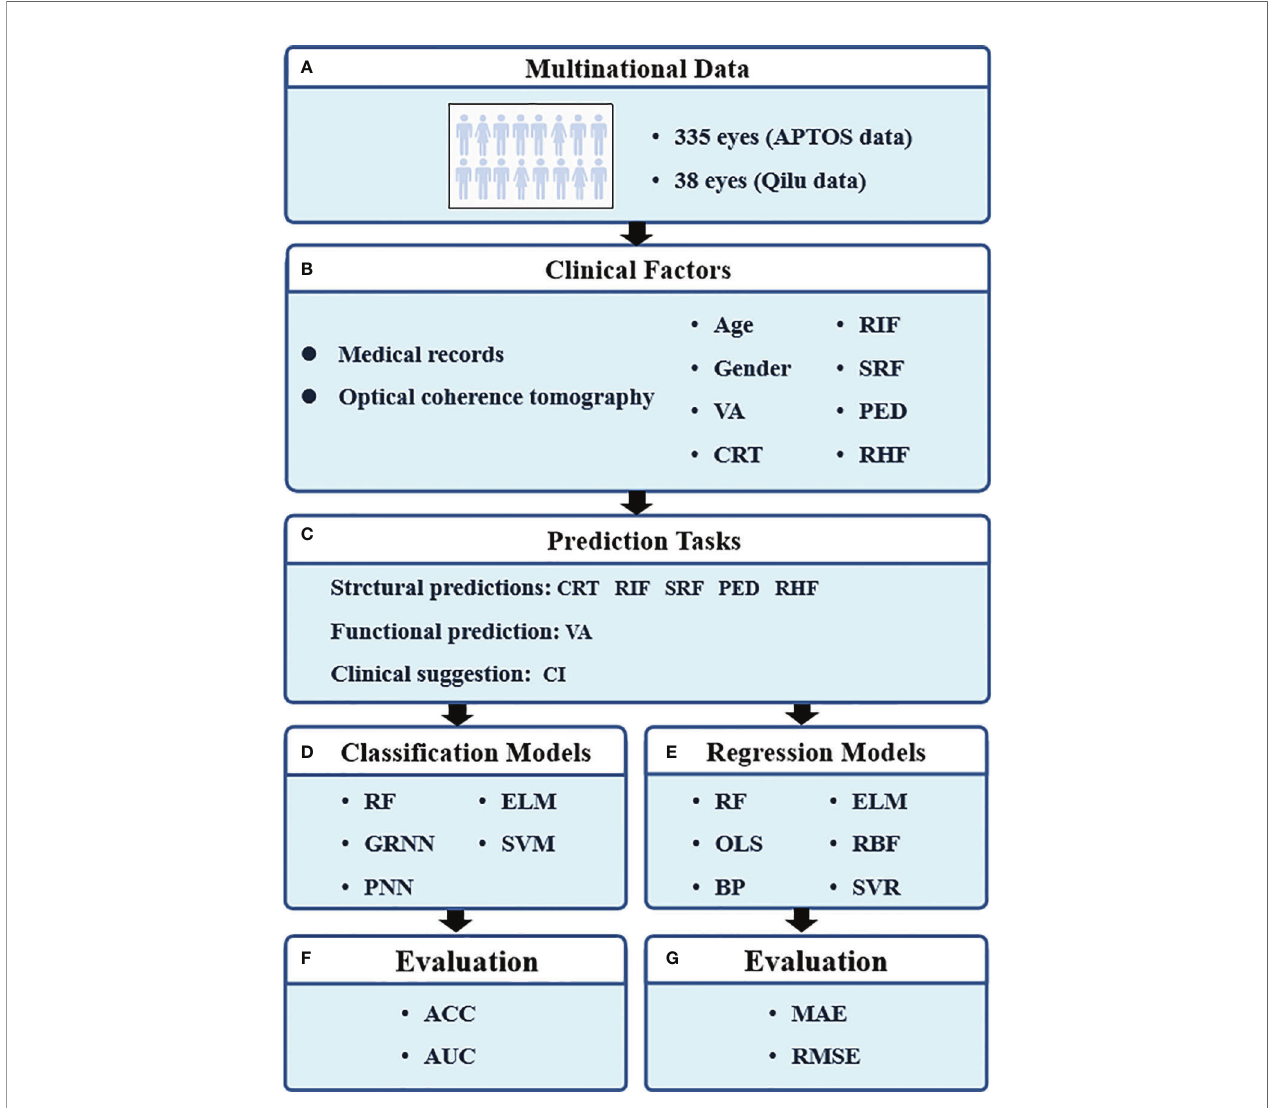
FIGURE 1 | The pipeline of our study. VA, visual acuity; CRT, central retinal thickness; RIF, retinal interlayer fl uid; SRF, subretinal pigment epithelium fl uid; PED, retinal pigment epithelial detachment; RHF, retinal hyperre fl exia; CI, continuous injection; RF, random forest; GRNN, generalized regression neural network; PNN, probabilistic neural network; ELM, extreme learning machine; SVM, support vector machines; OLS, ordinary least squares; BP, back propagation network; RBF, radial basis function network; SVR, support vector regression; ACC, classi fi cation accuracy; AUC, area under curve; MAE, mean absolute error; RMSE, root mean square